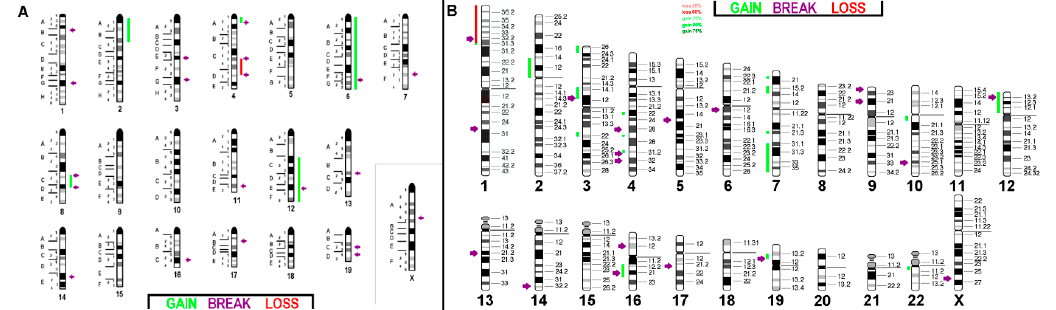
Table 2. Oncogenes and tumor suppresser genes of importance in BC according to the literature [25,26] and their involvement in gains or loss of copy numbers in the three studied cell lines. Abbreviation: CNV = copy number